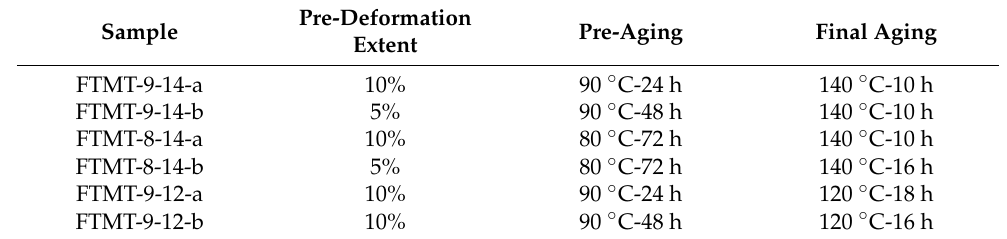
Table 3. Process stage and parameters for Al-5.8Mg-4.5Zn-0.5Cu alloy samples under different